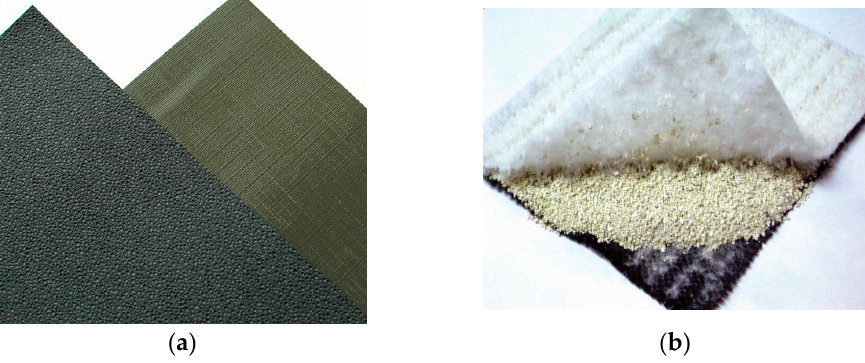
Figure 5. Examples of: ( a ) geomembrane; ( b ) geosynthetic clay layers.